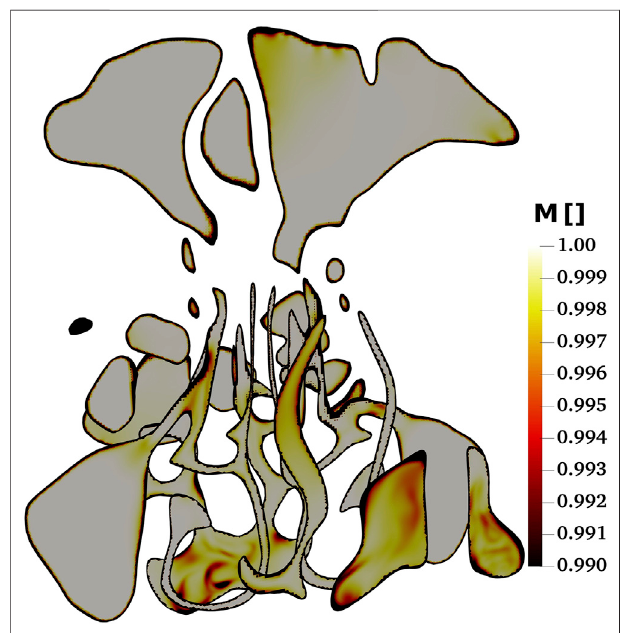
FIGURE3| Thecontourplotsofratioofresolvedturbulentkineticenergy (TKE) to total TKE as a control for the mesh quality of the present large eddy simulations (LES)